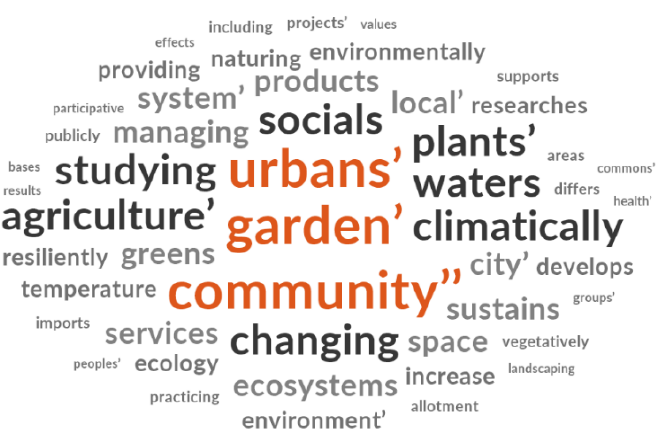
Figure 3. The 50 most frequent words in the full texts of the literature (n = 72) included.